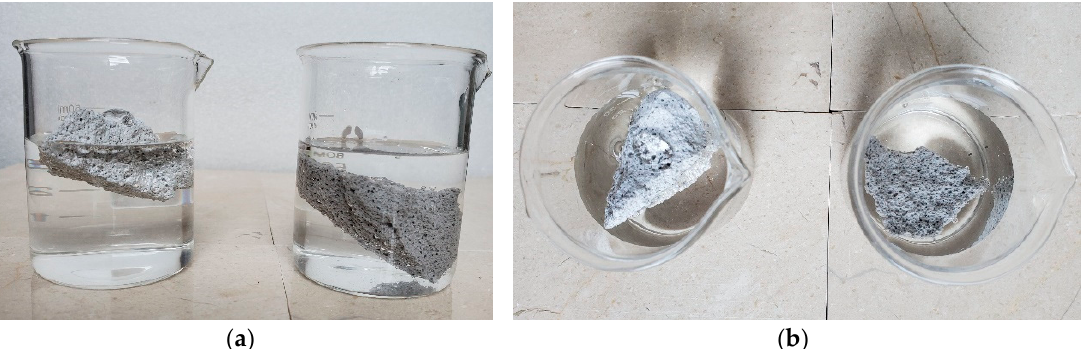
Figure 8. Water immersion experiment of the aerated bricks w/o surface modification: ( a ) Side view; ( b ) Top view.